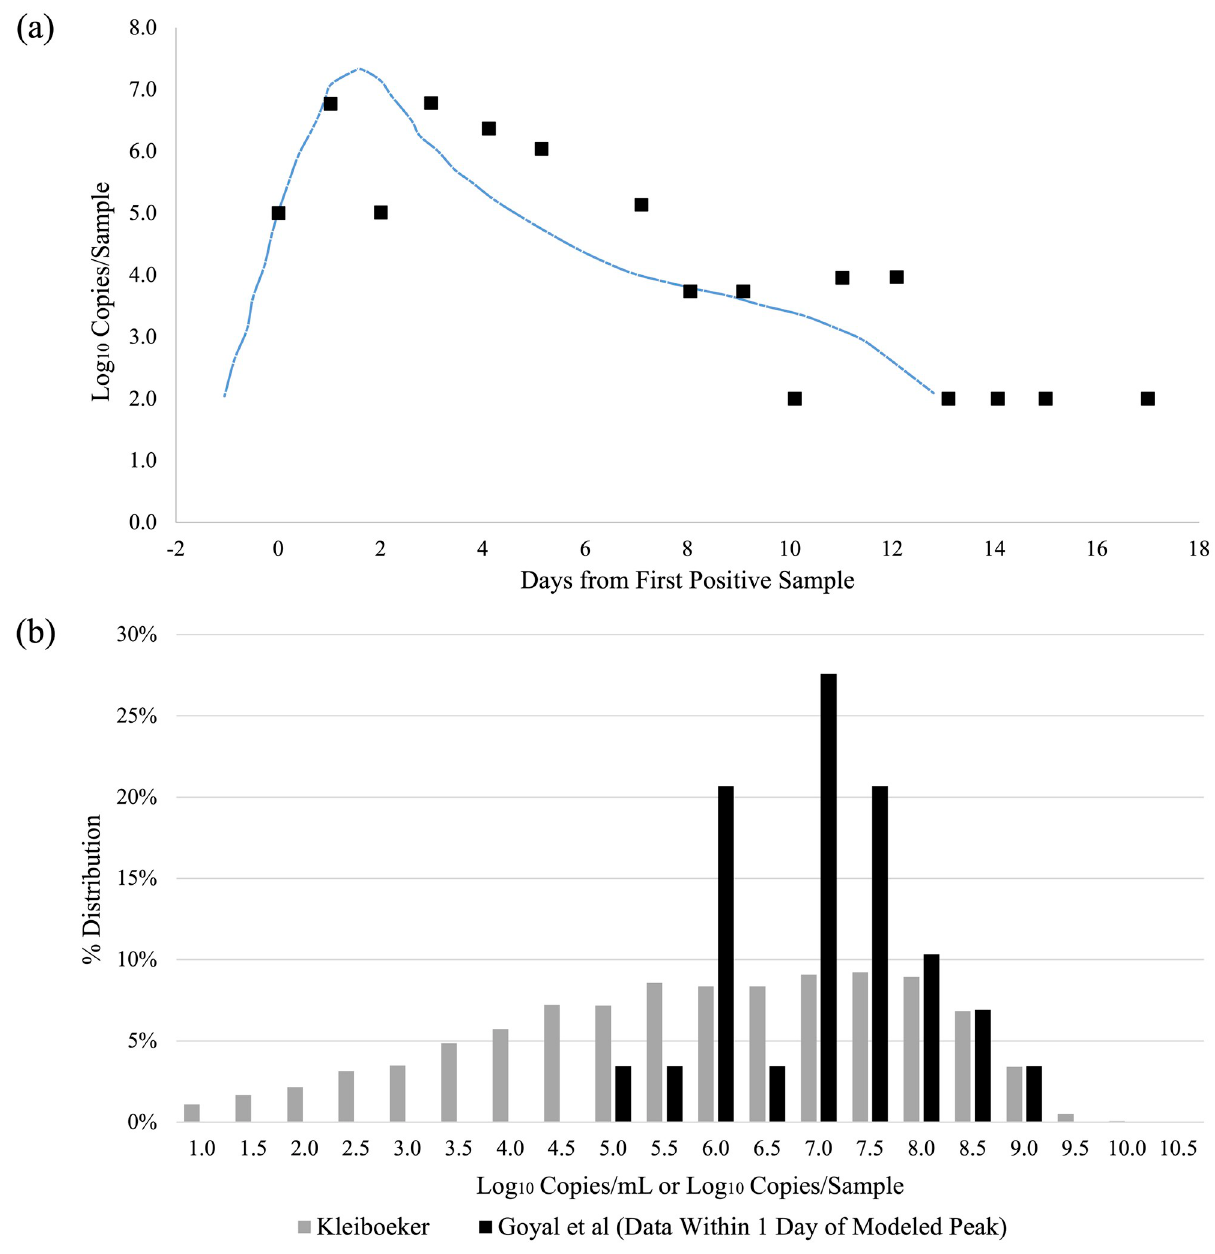
Fig 6. (a) Example Measured and Fit Viral Load Over Time (data and model shown from Patient S14 from Goyal et al .) [13]. The actual and modeled viral loads vary between * 2 and 7 Log10 copies/sample across the entire period, but the modeled viral load for this patient lies in a narrower range of * 6.3–7.3 Log10 copies/sample in the period which is ± 1 day around the time of peak viral load. (b) The grey bars are the distribution of viral loads (copies/mL) measured by Kleiboeker et al . The black bars are the distribution of viral loads (copies/sample) drawn from the 25 calibration datasets of Goyal et al ., but only for the 29 data points taken within ± 1 day of the modeled peak viral load. The distribution of peak values, which may be more representative of viral load in index patients of our case studies, is significantly narrower than the Kleiboeker